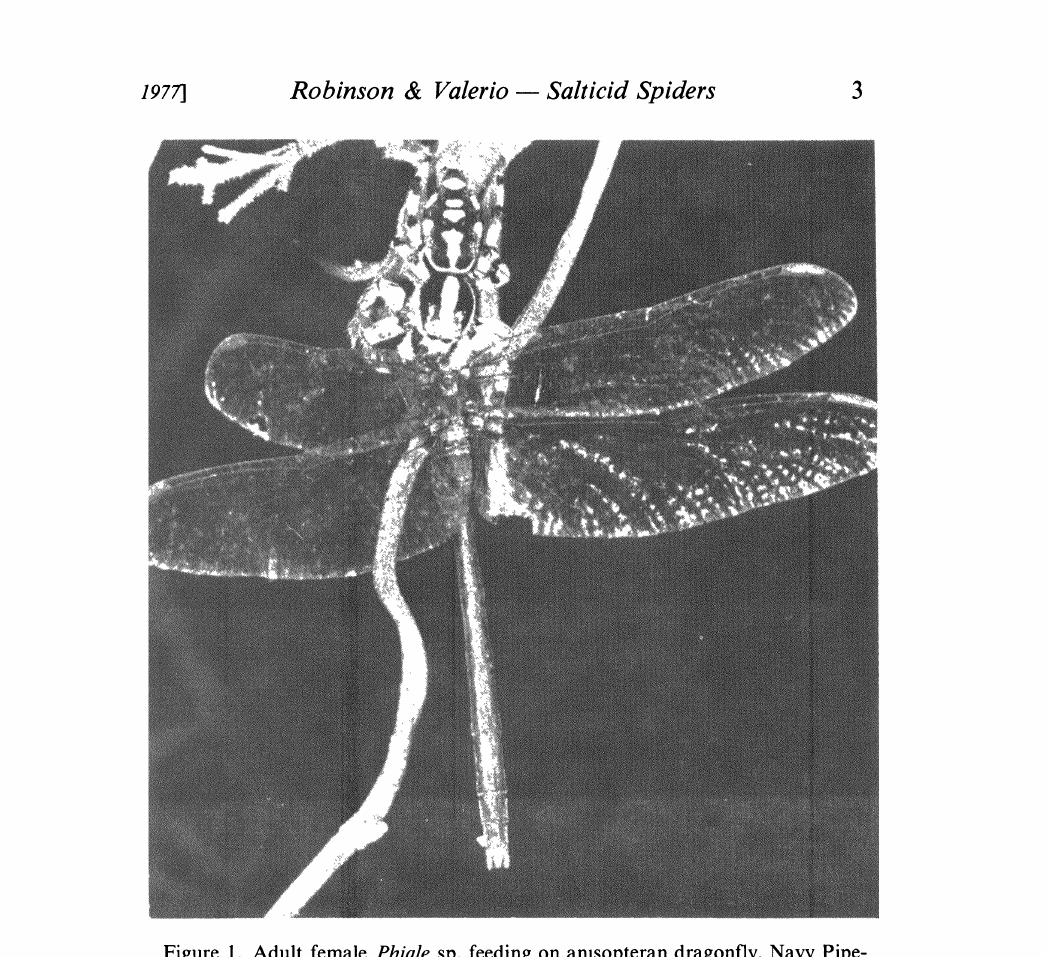
Figure 1. Adult female Phiale sp. feeding on amsopteran dragonfly, Navy Pipe- line Road, Canal Zone, Panama. June 18th